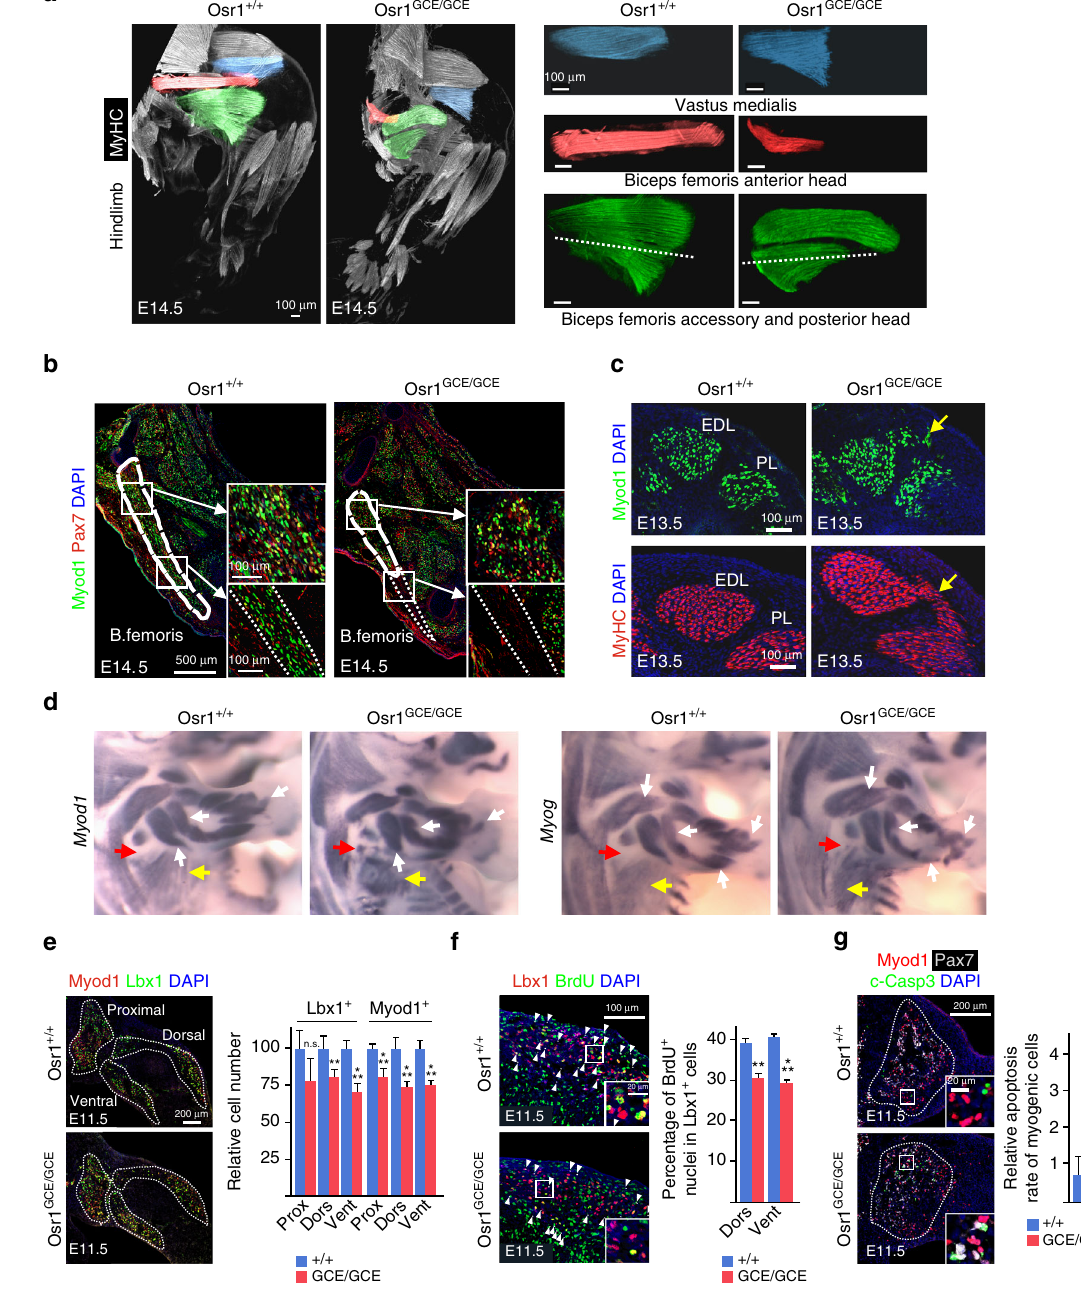
Fig. 5 Limb muscle patterning defects in Osr1 -de fi cient embryos. a Muscle pattern in hindlimbs of E14.5 Osr1 + / + and Osr1 GCE/GCE embryos assessed by whole limb immunolabelling for Myosin heavy chain (MyHC) followed by 3D reconstruction. Affected muscles are highlighted by false colours. Note truncations of several muscles. Scale bars: 100 μ m. b Sections of E13.5 hindlimbs, where the Biceps femoris muscle is highlighted. Section planes are indicated in green muscles (a, bottom right) by the dashed lines. The distal truncated region of the B. femoris muscle is devoid of myogenic cells in Osr1 mutants highlighted with dashed lines. In the residual B. femoris muscle of Osr1 mutants, myogenic cells appear in disarray (see high magni fi cations). Analysis was done on serial sections of whole limbs to exclude section artefacts. c Ectopic Myod1 + myoblasts and MyHC + myo fi bers between the Extensor digitorum longus (EDL) and Peroneus longus (PL) muscles in Osr1 mutants (yellow arrows). d Wholemount in situ hybridization on E13.5 Osr1 + / + or Osr1 GCE/GCE embryos for myogenic markers Myod1 and Myog . Misshaped muscle primordia in limbs (white arrows), disarrayed myo fi bres in the latissimus dorsi muscle (yellow arrows) and ectopic myoblasts (red arrows) are observed in Osr1 mutants. e Immunolabelling for Lbx1 and Myod1 on E11.5 limb sections shows a decrease in the overall number of myogenic cells in proximal, dorsal and ventral muscle primordia in mutant compared to wt embryos ( n = 3). f Reduced proliferation rate of Lbx1 + myogenic progenitors (dorsal: wt 38,6 ± 2,3%, mut 30 ± 1,8%; ventral: wt 41,1 ± 1,3%, mut 29,6 ± 1,0%) in E11.5 Osr1 mutants assessed by BrdU labelling ( n = 4). ( g ) Increased apoptosis in myogenic cells in Osr1 mutants assessed by immunolabelling for cleaved (activated) Caspase 3 (c-Casp3) ( n = 3). Error bars represent s.e.m. T-test: * = p < 0.05; ** = p < 0.01; *** = p < 0.001. N-numbers indicate biological